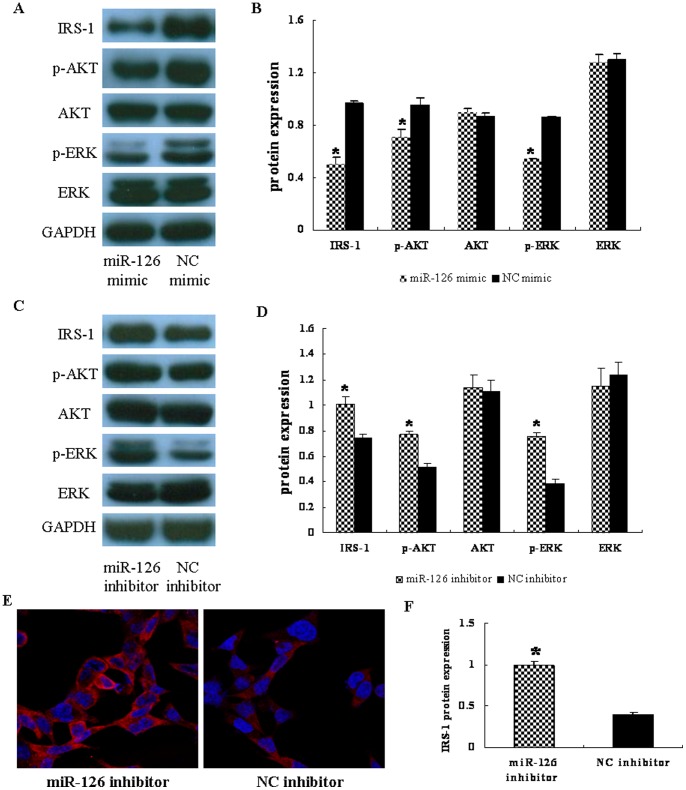
Alteration of microRNA 126 (miR-126) influences AKT and ERK1/2 activation by targeting insulin receptor substrate 1 (IRS-1).(A) HT-29 cells were transfected with miR-126 mimic or negative control (NC) mimic, and total proteins from the cells were used to detect IRS-1, p-AKT, total-AKT, p-ERK1/2, total-ERK1/2, and glyceraldehyde-3-phosphate dehydrogenase (GAPDH) expression by western blotting. (B) Relative protein levels were normalized to those of GAPDH and represented as mean ± SD from three experiments. *, indicates that the expression levels of IRS-1, p-AKT, and p-ERK1/2 were significantly lower in miR-126 mimic transfected cells than that of the negative control (NC) mimic group (P<0.05). (C) HCT-116 cells were transfected with miR-126 inhibitor or negative control (NC) inhibitor, and the above proteins were detected by western blotting. (D) Relative protein levels were normalized to those of GAPDH and represented as mean ± SD from three experiments. *, indicates that the expression levels of IRS-1, p-AKT, and p-ERK1/2 were significantly increased in the miR-126 inhibitor group when compared to the NC inhibitor group (P<0.05). (E) HCT-116 cells stained for IRS-1 by immunofluorescence. IRS-1 was expressed in the cytoplasm and the levels were significantly increased in miR-126 inhibitor-transfected cells. Red, IRS-1; blue, 4′,6-diamidino-2-phenylindole nuclear staining. Pictures were imaged at 630× magnification on a Leica converted fluorescence microscope. (F) Fluorescence intensity of IRS-1 in each group was then calculated. Data are presented as mean ± SEM of three independent experiments (*P<0.05 compared to that of NC inhibitor).